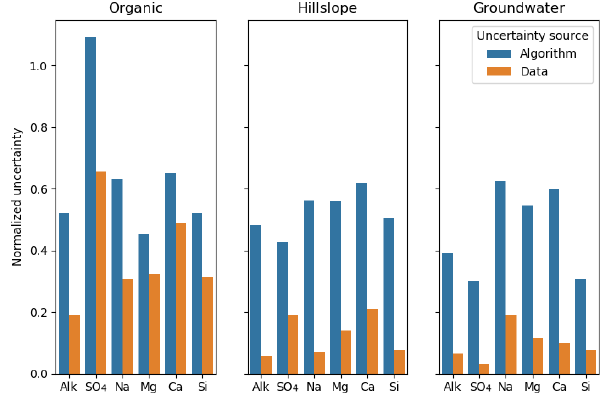
Figure 7. The normalized uncertainty of predicted end-members, where the uncertainty sources are from algorithm and data groups using the Panola data. The algorithm and the data are two groups that used the bootstrap method. Normalized uncertainties are esti- mated by dividing standard deviation of bootstrapped dataset over the standard deviation of stream water solute